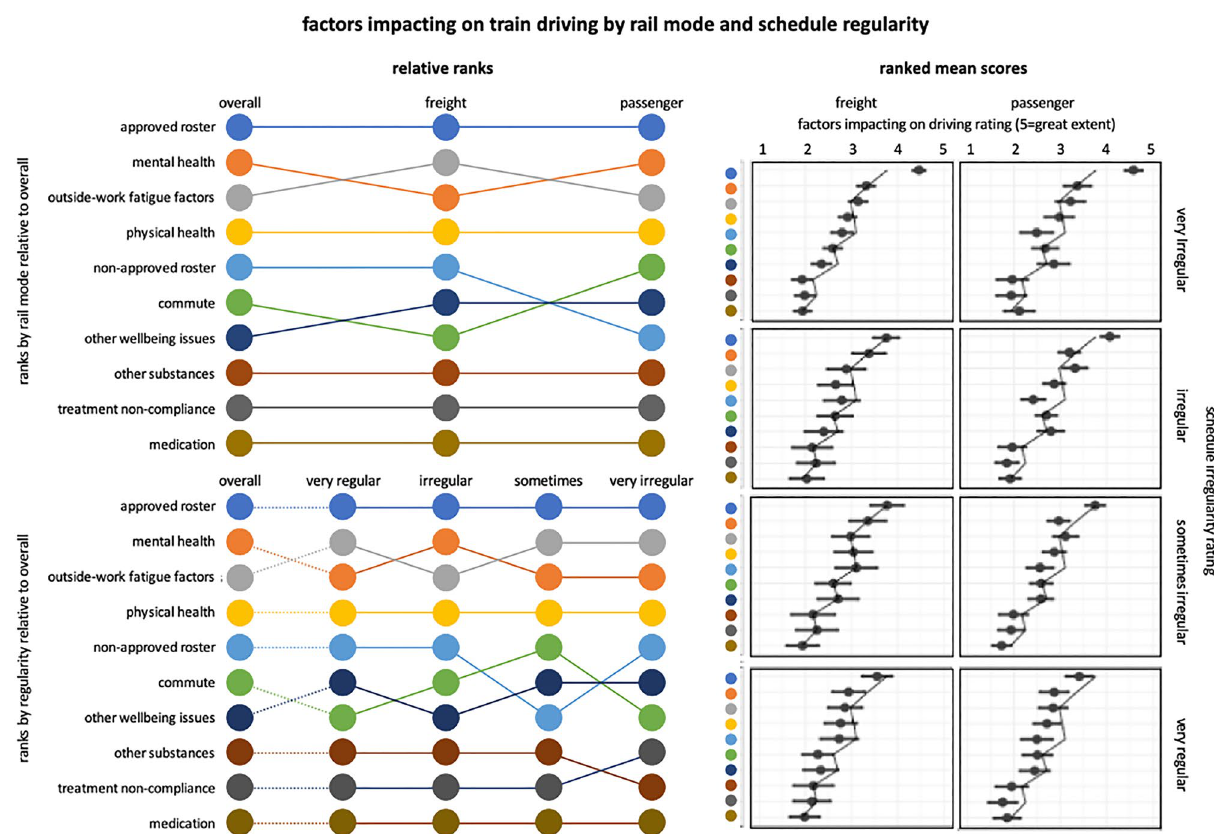
Figure 5. Bump Chart (left) displays ranking (according to mean rating on each scale, top = highest) of each of the fatigue, health, and wellbeing factors impacting on driving performance shown overall, and split by driving mode (upper) and regularity (lower). Plot matrix (right) display means (whiskers = sem) for each of the factors, ranked by mean rating, split by schedule regularity (rows), and rail mode